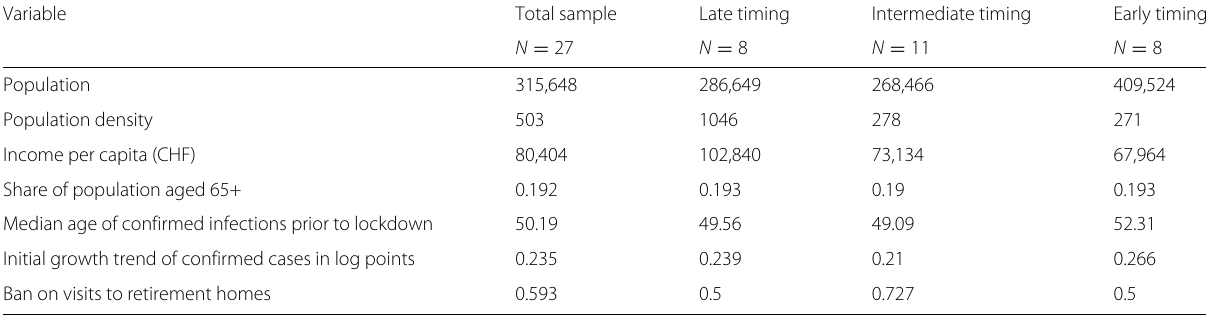
Table 3 Means of covariates considered in the estimations using the Swiss (and LI) data in the total sample, the late intervention group, the intermediate intervention group, the early intervention group, the group of counties with curfew, and the group of counties without curfew,